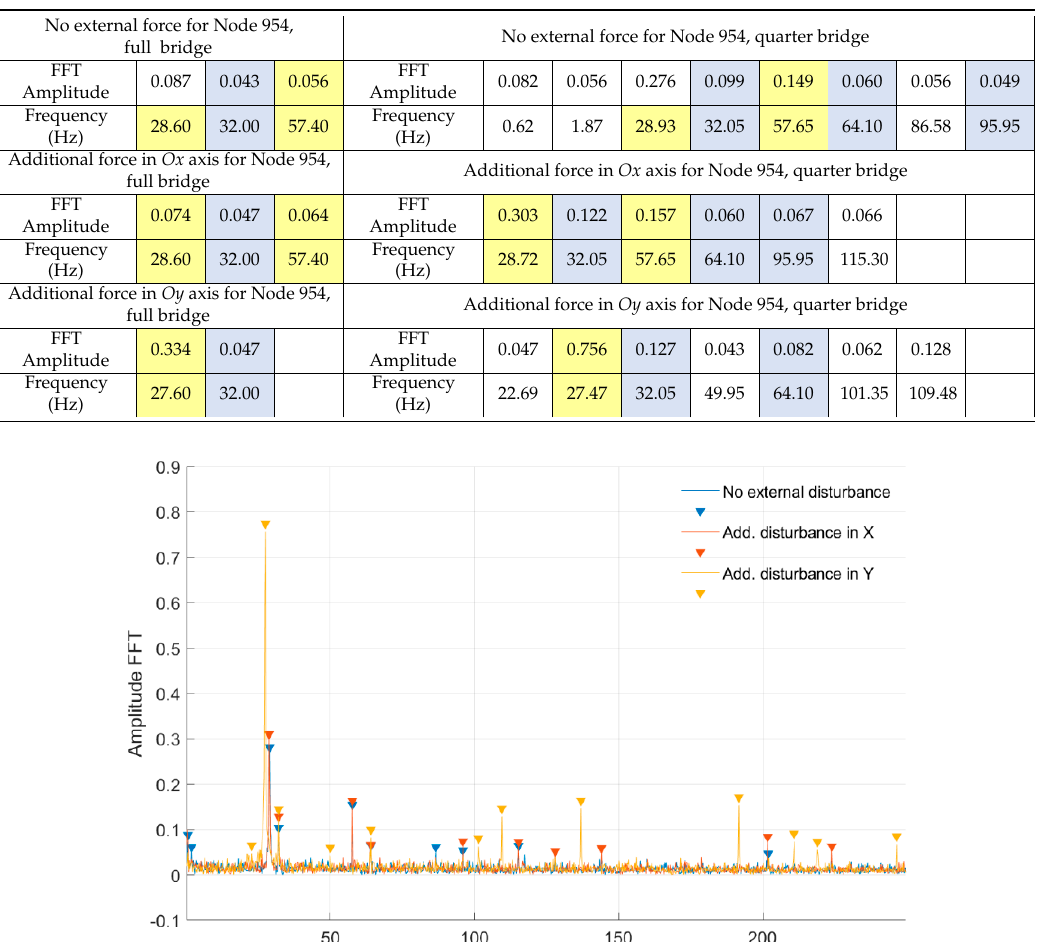
Table 2. List of parameters read from the characteristics shown in Figures 10 and 11.